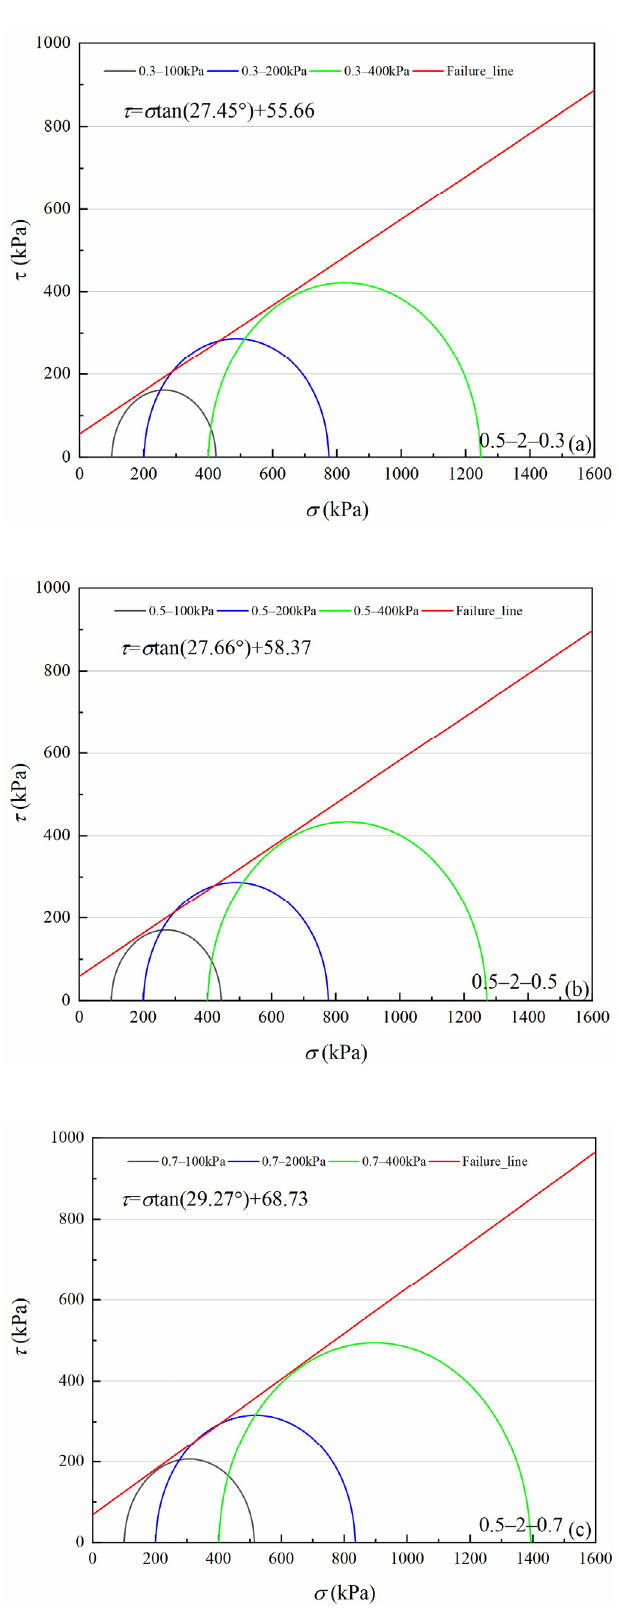
Figure 8. Shear strength envelopes of 0.5–2 mm particle groups volcanic soil with different relative density ( Dr ) under the peak state: ( a ) Dr = 0.3, ( b ) Dr = 0.5, ( c ) Dr = 0.7.